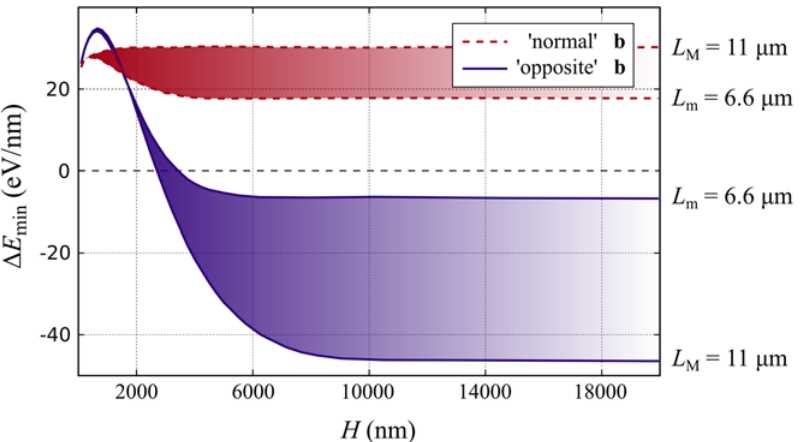
Figure 13. Model results. Energy gain for the introduction of the first ‘normal’ (red-dashed curve) or ‘opposite’ (purple solid curve) dislocations in under-etched pillars with base L with respect to the pillar height H. The formation energy is negative only for dislocations with the ‘opposite’ Burgers vector b . Reproduced with permission from [46]. American Physical Society.